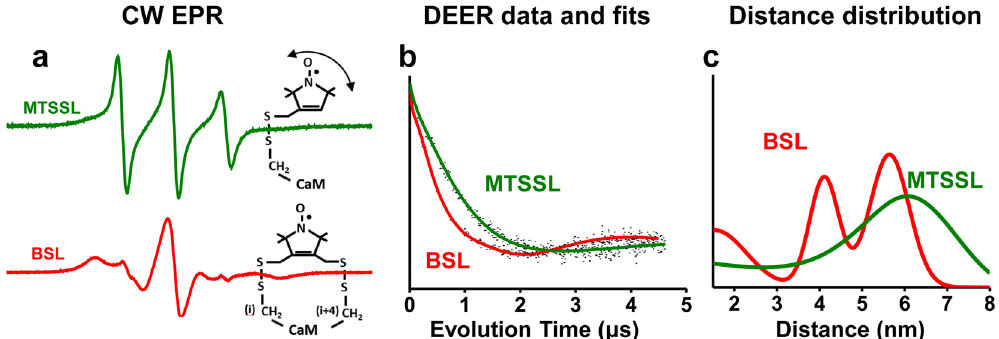
Figure 5. Comparison of MTSSL (green) and BSL (red) in detecting backbone dynamics and distance distributions within CaM. ( a ) CW EPR spectra at 4 °C, showing that BSL (labeled at position T34CS38C) is strongly immobilized (broad spectrum) on CaM, accurately detecting backbone dynamics, while MTSSL (labeled at position T34C) is weakly immobilized, indicating spin label flexibility (double-headed arrow). ( b ) Background-corrected DEER echo decay of double BSL-CaCaM (T34CS38C-R106CT110C) and double MTSSL-CaCaM (T34C-T110C). ( c ) DEER distance distributions demonstrating the resolving power of BSL. MTSSL reveals two unresolved, broad distance distributions (green) while BSL reveals three distinct distance populations (red). CW EPR spectra in A were obtained with a 120 G scan width, then normalized to unit spin concentration by dividing by the double